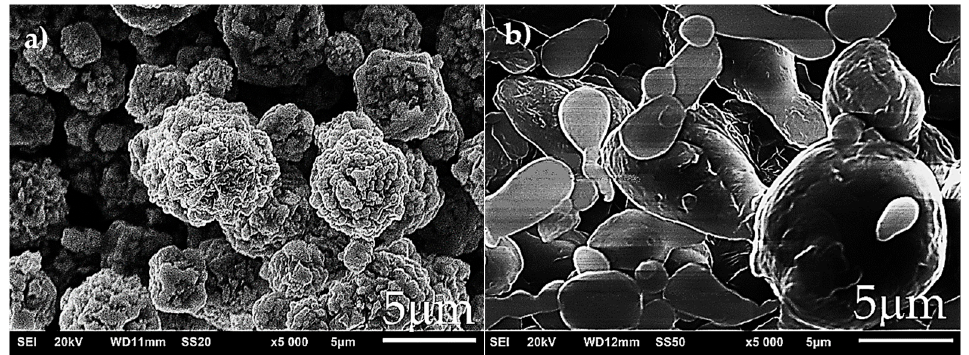
Figure 1. SEM micrographs of ( a ) nickel and ( b ) aluminum powders.